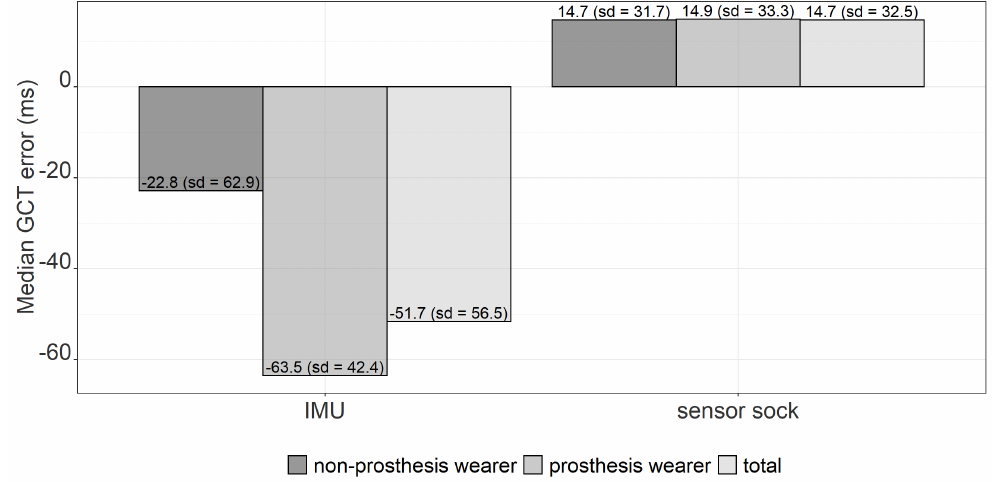
Figure 7. Median GCT error between the Suralis system wearables (IMU/sensor sock) and the ground truth for prosthesis wearers and non-prosthesis